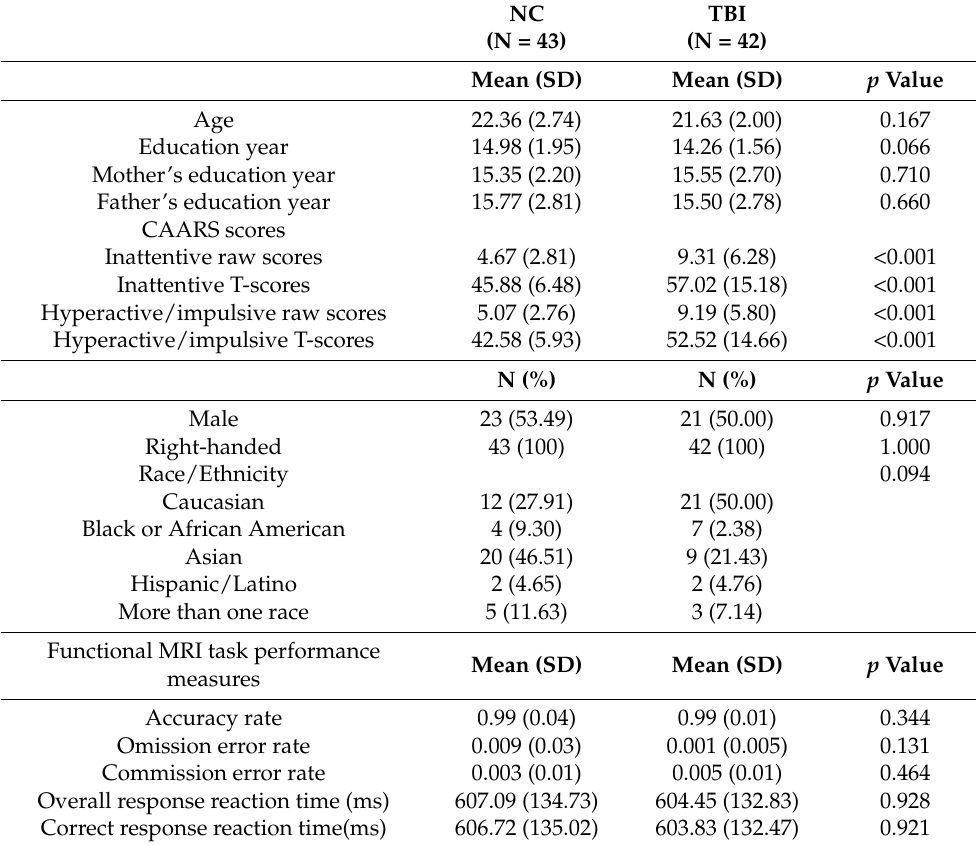
Table 1. Demographic, clinical/behavioral, and task-performance measures of the study